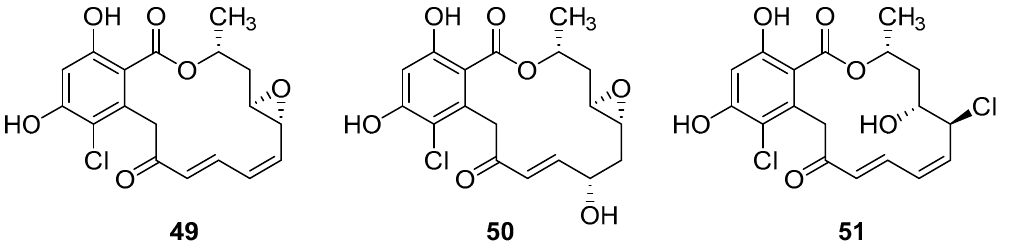
Figure 22. Structures of radicicol ( 49 ), pochonin B ( 50 ), pochonin C ( 51 ).